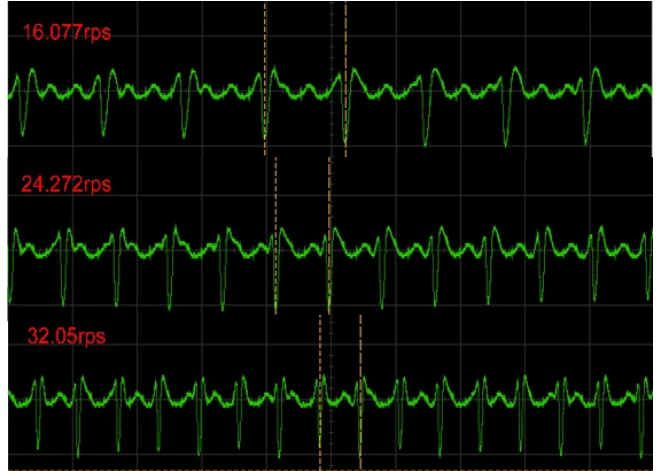
Figure 8. The demodulated voltage signal as a function of time for different rotation speeds in the oscilloscope.